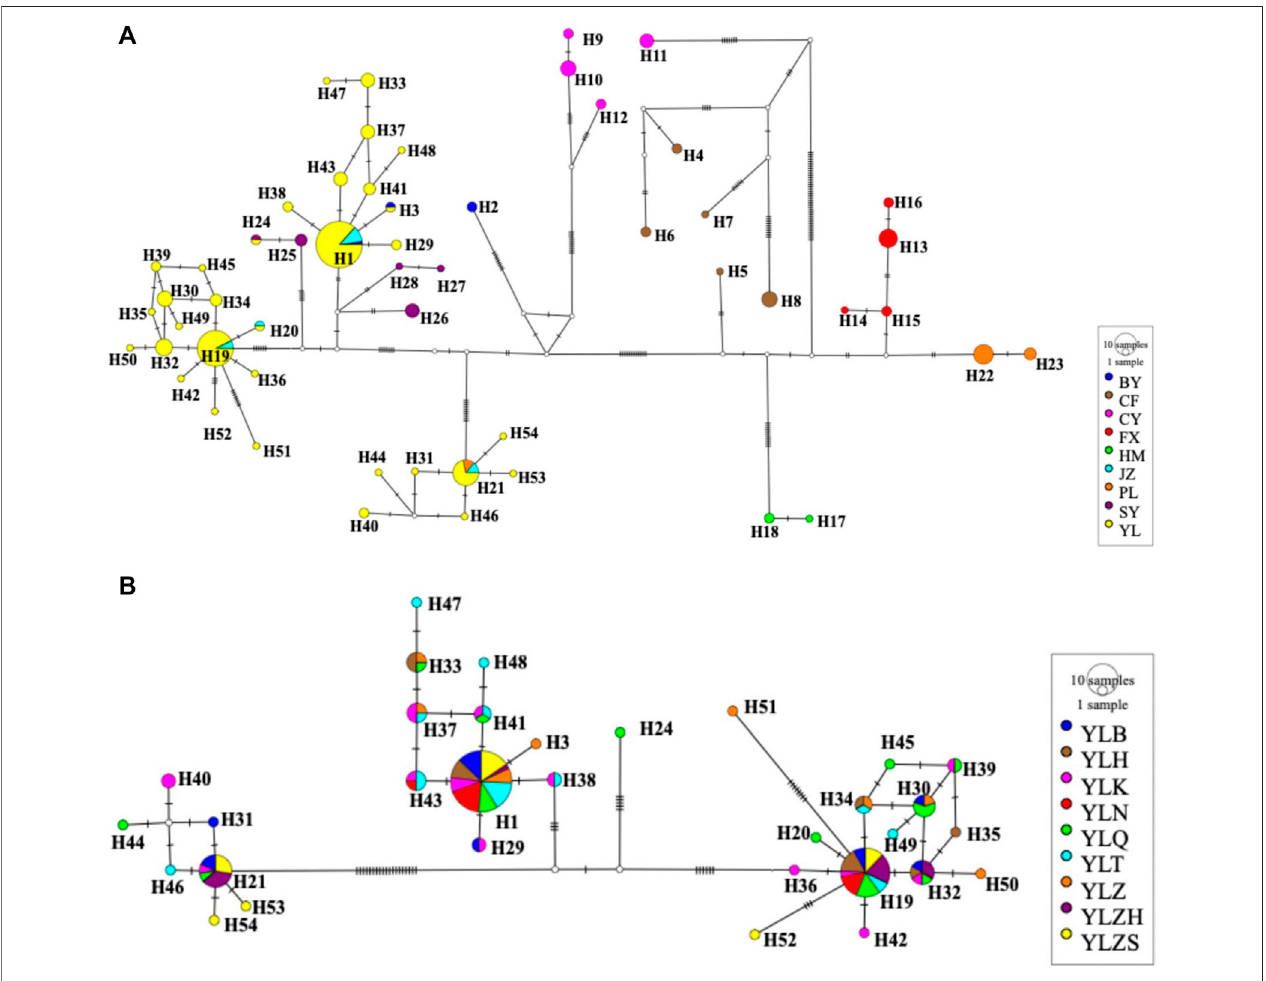
FIGURE 4 | Median-joining haplotype networks of 17 different populations (A) and the YL group (B) of A. mali based on concatenated genes. Colored circles represent different haplotypes, solid lines between haplotypes represent mutation steps. The area of the circle is proportional to the number of haplotypes.